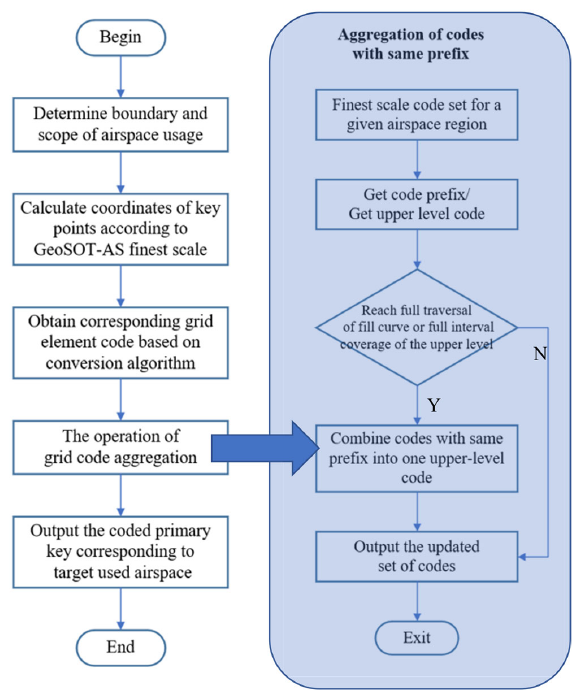
Figure 8. ADS ‐ B data extraction algorithm flow chart. Figure 8. ADS-B data extraction algorithm flow